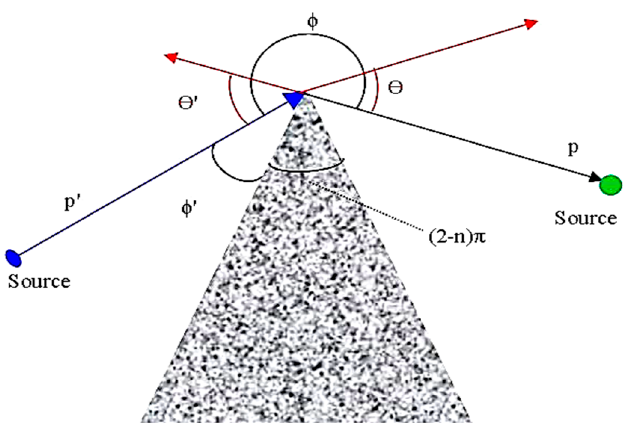
Figure 7. Schematic of cone diffraction.